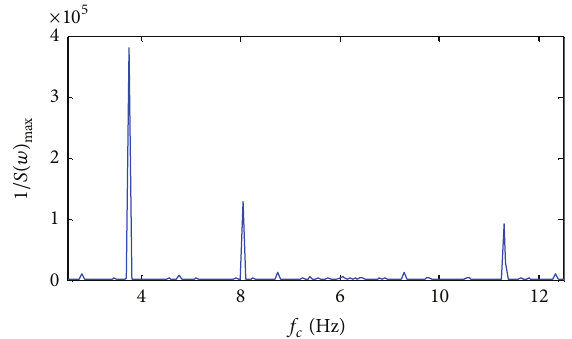
Figure 9: The change curve about the reciprocal of the stochastic resonance output signal spectrum peak with the adjustment of 𝑓 𝑐 in the multiple high